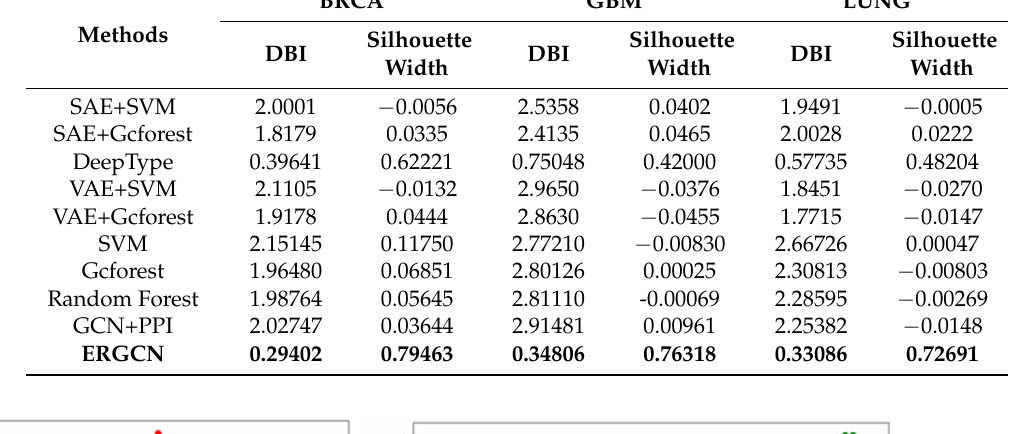
Table 4. The internal evaluation metrics of every model.